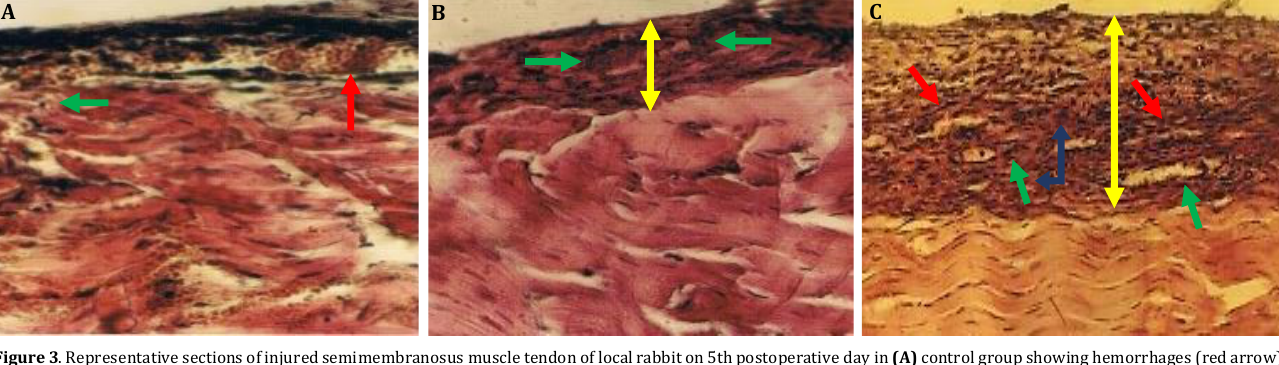
Figure 3 . Representative sections of injured semimembranosus muscle tendon of local rabbit on 5th postoperative day in (A) control group showing hemorrhages (red arrow), neutrophils (green arrow), H&E, 40×; (B) Group A, irradiated with diode impulse laser at 1800 rad for 15 min showing thick epitenon (yellow double-arrow), neutrophils (green arrows), H&E, 40×; (C) Group D, irradiated with diode impulse laser at 4200 rad for 35 min showing thicker epitenon (yellow double-arrow), severe infiltration of inflammatory cells (green arrows), fibroblasts (red arrows), and collagen fibers precipitation (blue left-up arrow), H&E,